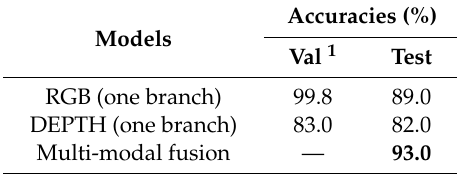
Table 3. Performance comparison of the di ff erent models. (The best performance is depicted in bold).